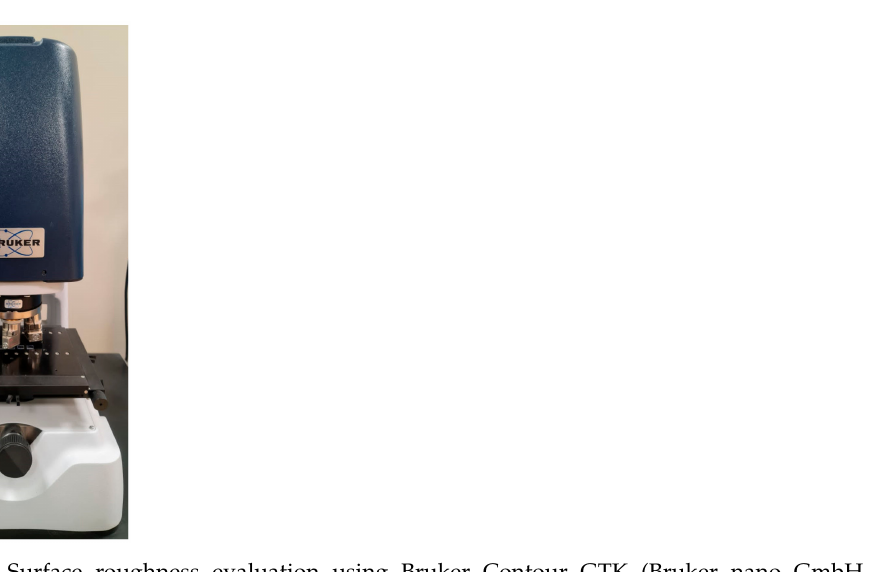
Figure 6. Surface roughness evaluation using Bruker Contour GTK (Bruker nano GmbH, Berlin, Germany).